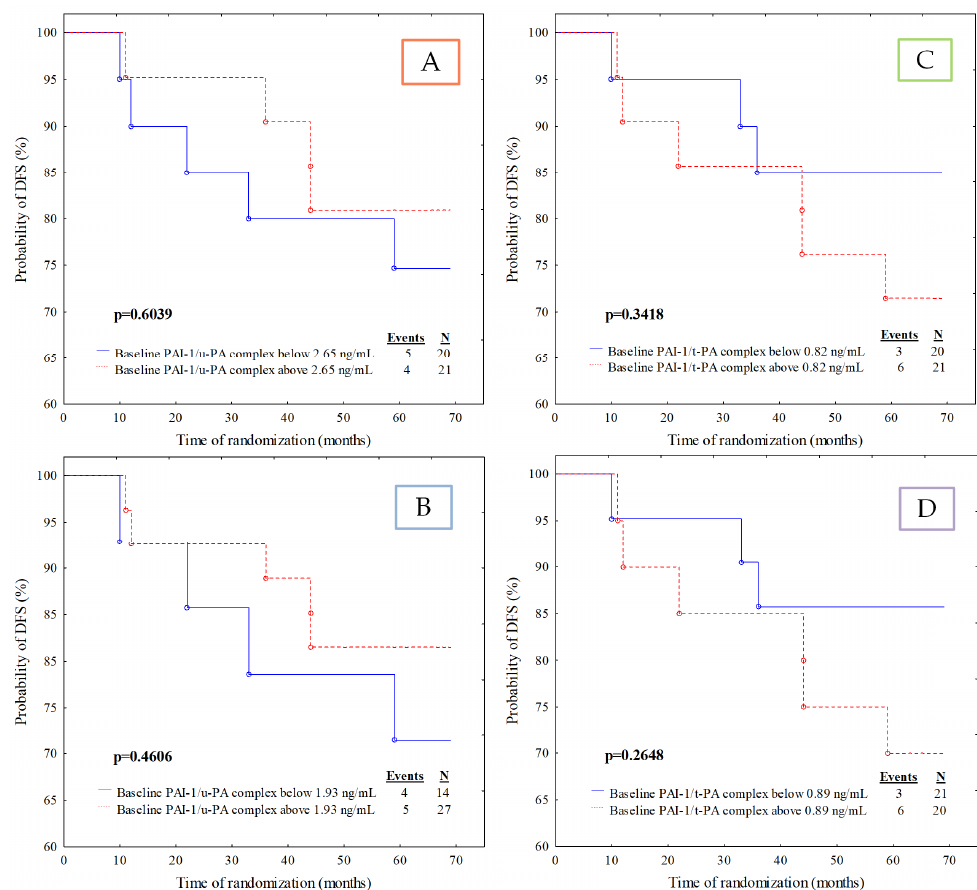
Figure 5. Kaplan–Meier curves for the disease-free survival (DFS) analysis of the studied population regarding ( A ) PAI-1/u-PA complex divided according to median value cut-off; ( B ) PAI-1/u-PA complex divided according to ROC cut-off; ( C ) PAI-1/t-PA complex divided according to median value cut-off; ( D ) PAI-1/t-PA complex divided according to ROC cut-off. 3.5. Potential Associations of the Disease-Free Survival with Fibrinolytic Parameters Table 6. Logistic regression analysis of disease-free survival predictors in breast cancer patients. A univariate logistic regression analysis was used to predict the risk of developing breast cancer recurrence as contributed by the fibrinolytic profile. Table 6 shows the odds Disease-Free ratio (OR) of recurrent breast cancer according to fibrinolytic parameters. It was found Variable Code that only t-PA antigen significantly contributed to the disease-free survival. An increase of 1 ng/mL in t-PA antigen level was found to reduce the risk of breast cancer relapse by 0.06 (OR) (95% CI = 0.01 to 0.68; p = 0.0209).